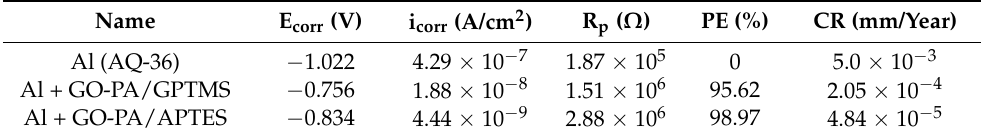
Figure 16. Curves of Tafel polarization, related to different coating samples (GO-PA/GPTMS and GO-PA/APTES) on aluminum ( a ) and steel substrates ( b ). Table 4. Calculation parameters for AQ-36 aluminum samples.